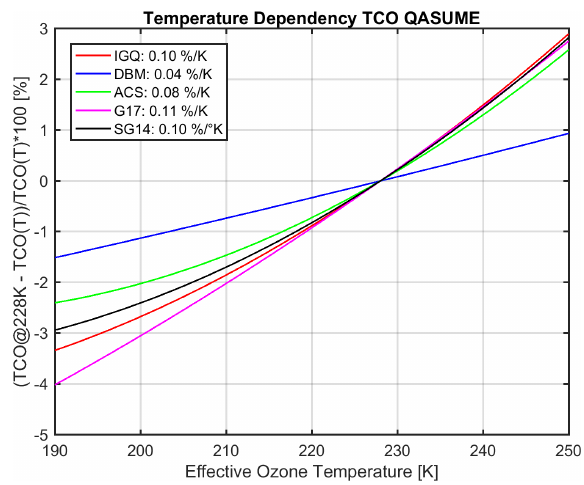
Figure 4. Dependency on effective ozone temperature of five dif- ferent cross